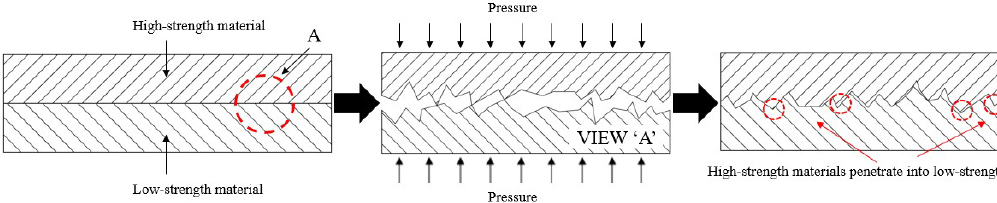
Figure 2. Schematic illustration of bonding area between two materials.